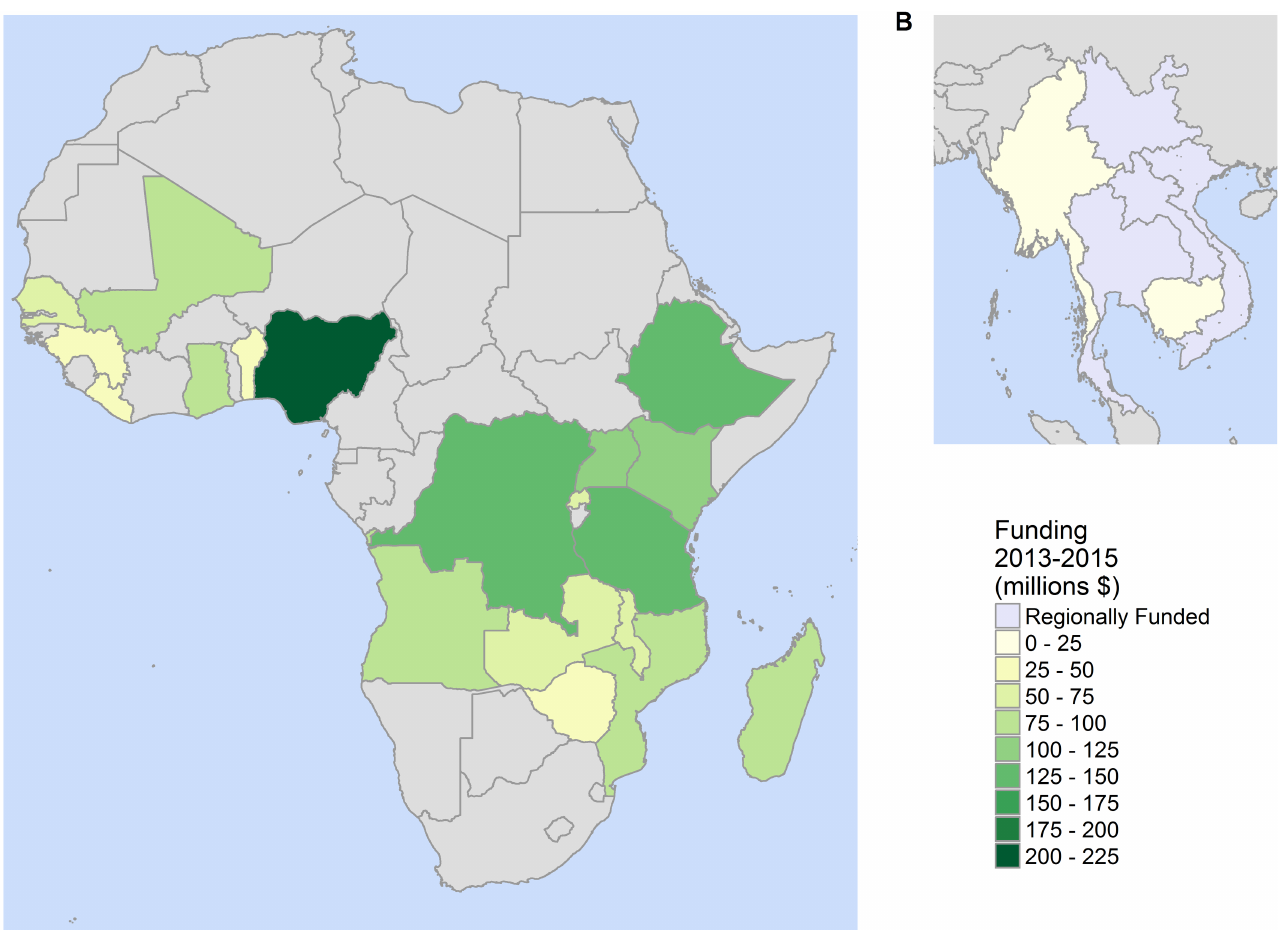
Fig 2. Map of PMI activities. Individual countriesand regions that have receivedPMI-fundingand support are highlightedto reflect the level of funding from PMI in (A) sub-Saharan Africa and (B) the GMS over the period2013–2015.The total regionalassignmentto the 6 GMS countriesover this period is US$9.5 million. Estimated fundingper populationat risk over this periodrangedfrom US$0.54(Myanmar) to US$8.08(Liberia). GMS, Greater Mekong Subregion; PMI, President’sMalaria Initiative.